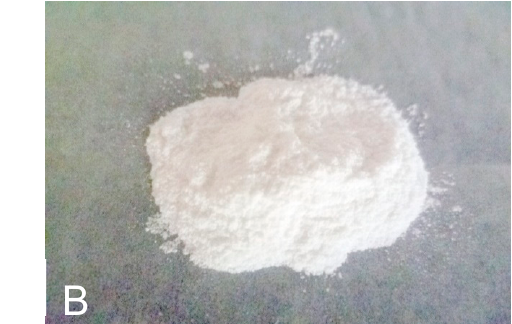
y = 53.174x - 0.0293 R² = 0.9994